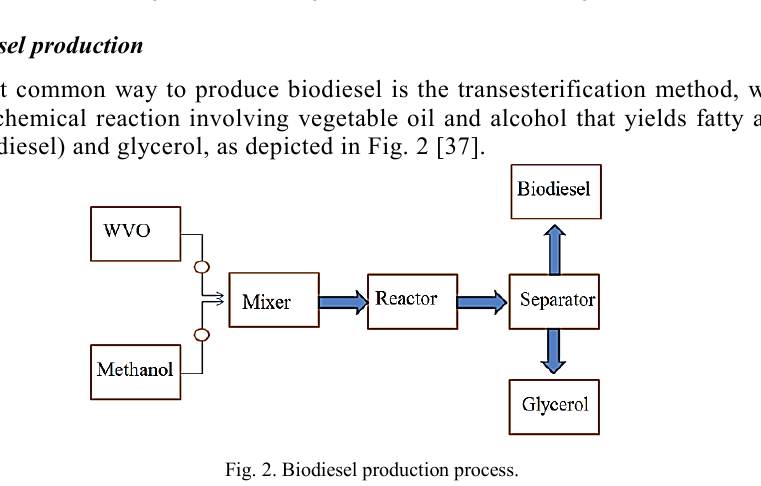
Fig. 1. Conversion stages of WVO into electric car charger.